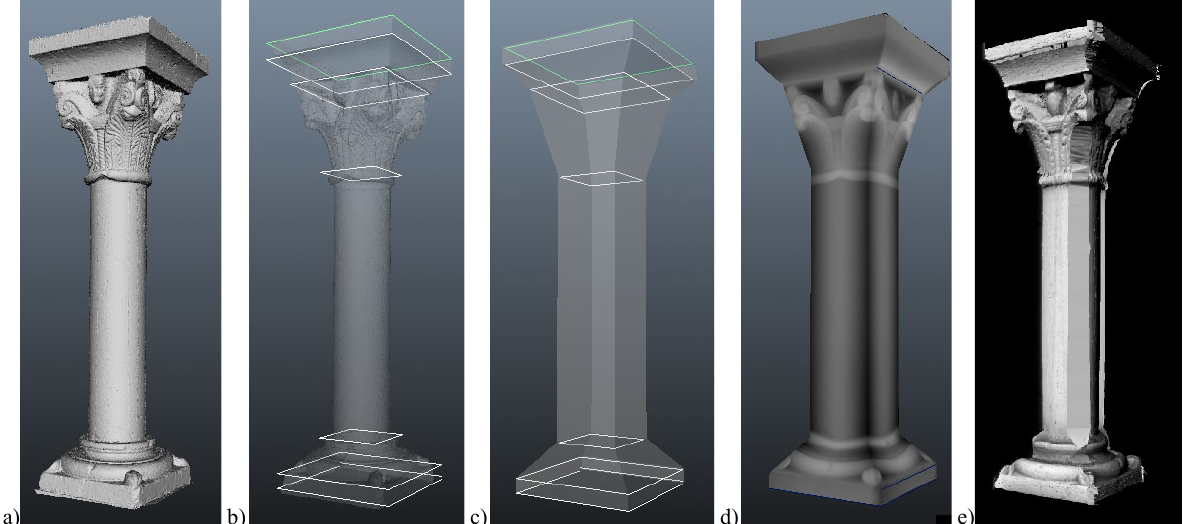
Figure 2: The reconstructed column, planes in correspondence of the identified shape transitions, the basic primitives fitted between the planes, the disparity map derived from the geometric details and mapped onto the basic primitives and the final light and efficient-in-size 3D model of the column textured with a displacement